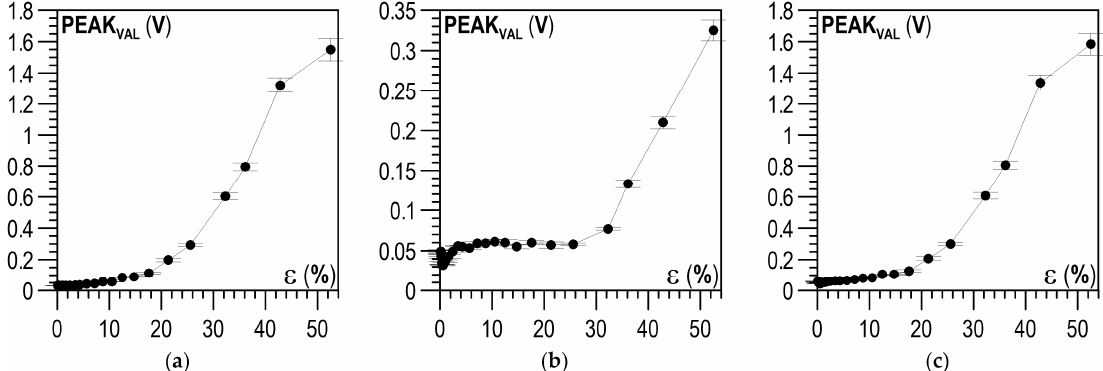
Figure 16. Relation between plastic deformation ε and mean PEAK VAL for descending halves of magnetisation I ↘ : ( a ) parallel direction; ( b ) perpendicular direction; ( c ) module of directions.